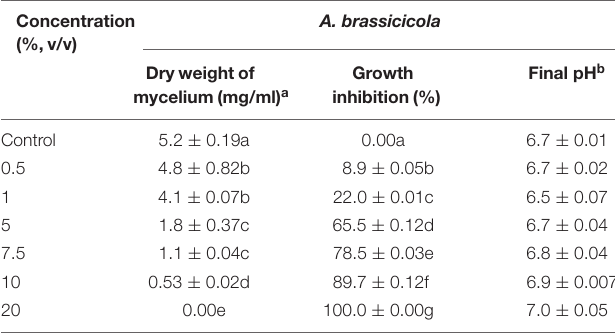
TABLE 1 | Effect of filter sterile culture supernatant of Streptomyces hydrogenans DH16 on mycelial growth of Alternaria brassicicola when supplemented in potato dextrose broth at different